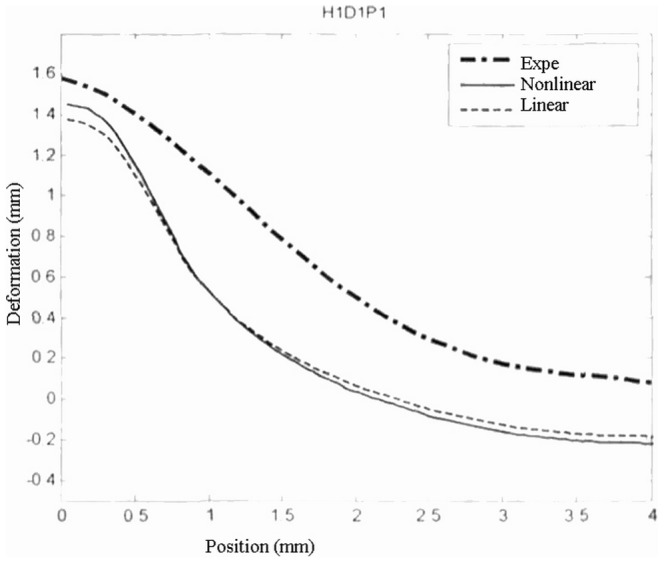
Finger deformation with H1D1P1.